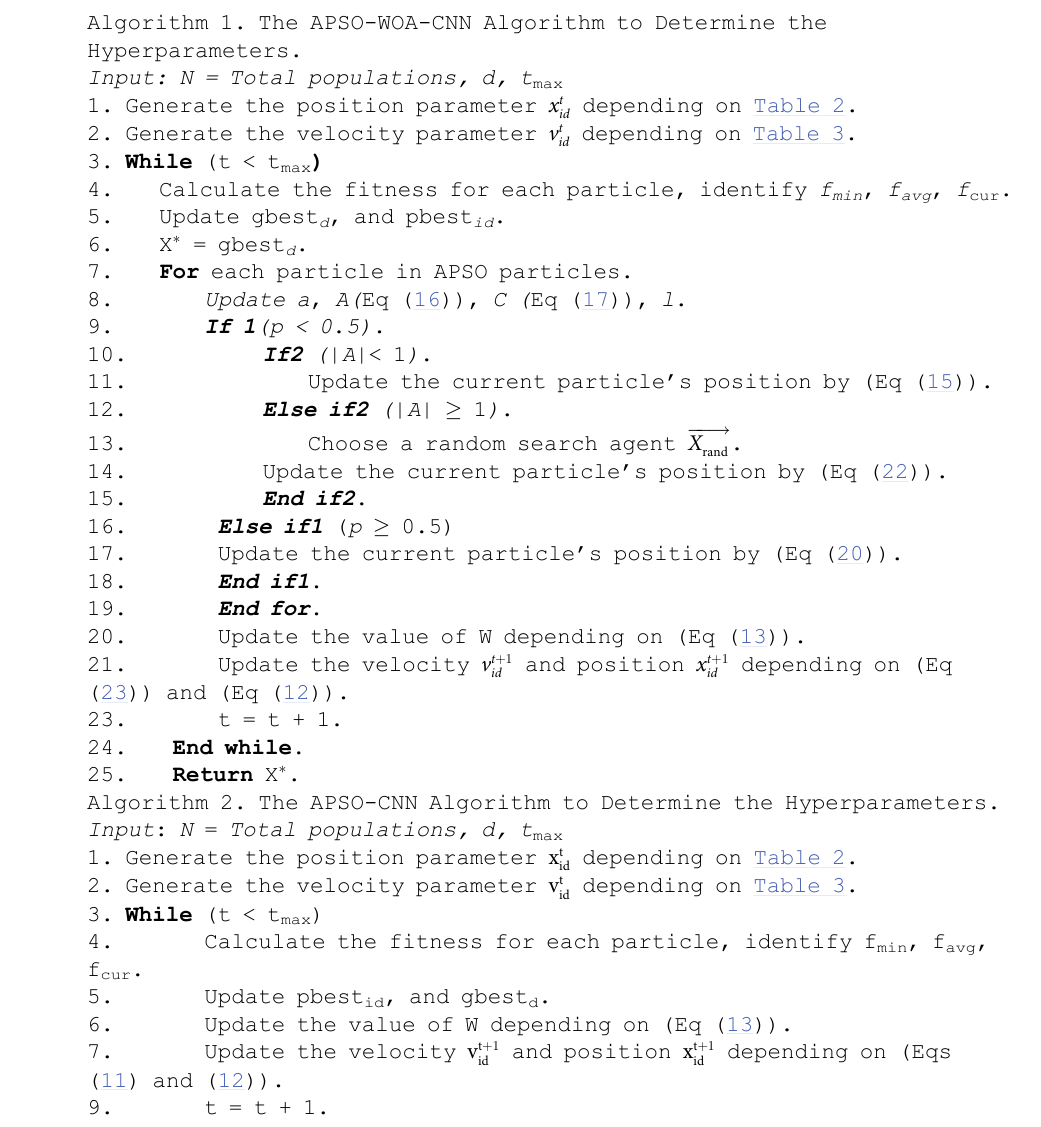
Algorithm 2. The APSO-CNN Algorithm to Determine the